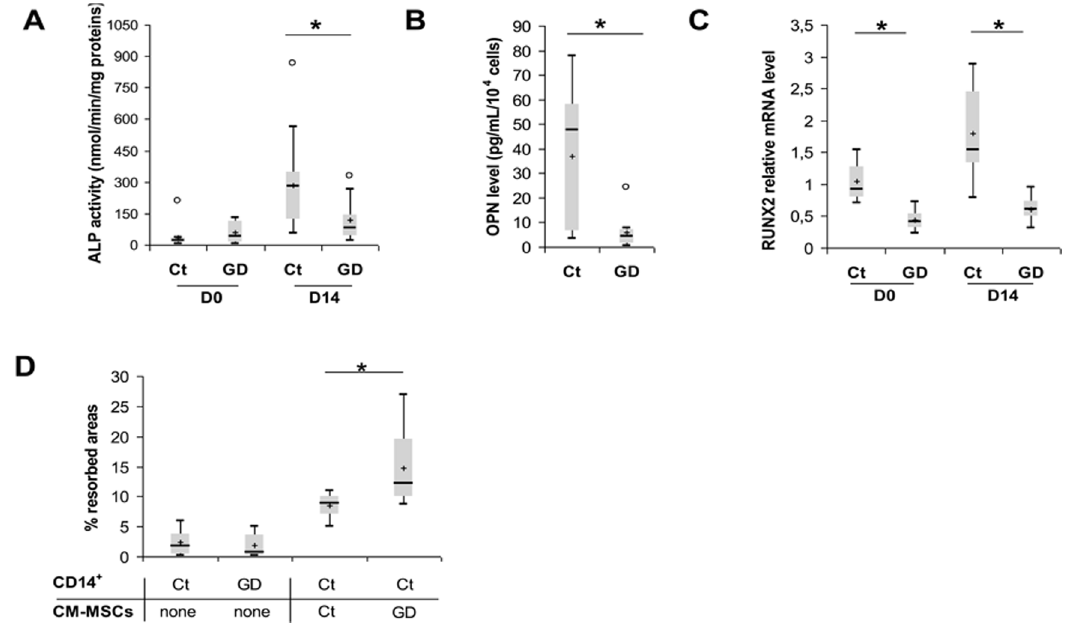
Figure 4. Osteoblastic and osteoclastic balance in GD. MSCs osteogenic differentiation: (A) Box plots represent ALP activity at D0 and after 14 days of differentiation for Ct and GD. Results are expressed as nmol/min/mg protein (n=10). (B) Osteopontin levels were measured by ELISA at D0 and D14 after differentiation in culture supernatants of Ct and GD-MSCs (n=10). (C) Relative expression of osteogenic transcription factor RUNX2 measured by RTqPCR at D0 and D14 after differentiation (n=10). (D) Resorption activity of CD14 + -derived osteoclasts cultured on biocoat bone matrix in osteoclastic media: Quantification of resorption potential of monocytes-derived osteoclasts from Ct or GD after 14 days of differentiation or from Ct-osteoclasts in the presence of Ct or GD treated MSCs conditioned media (CM) (n=6).